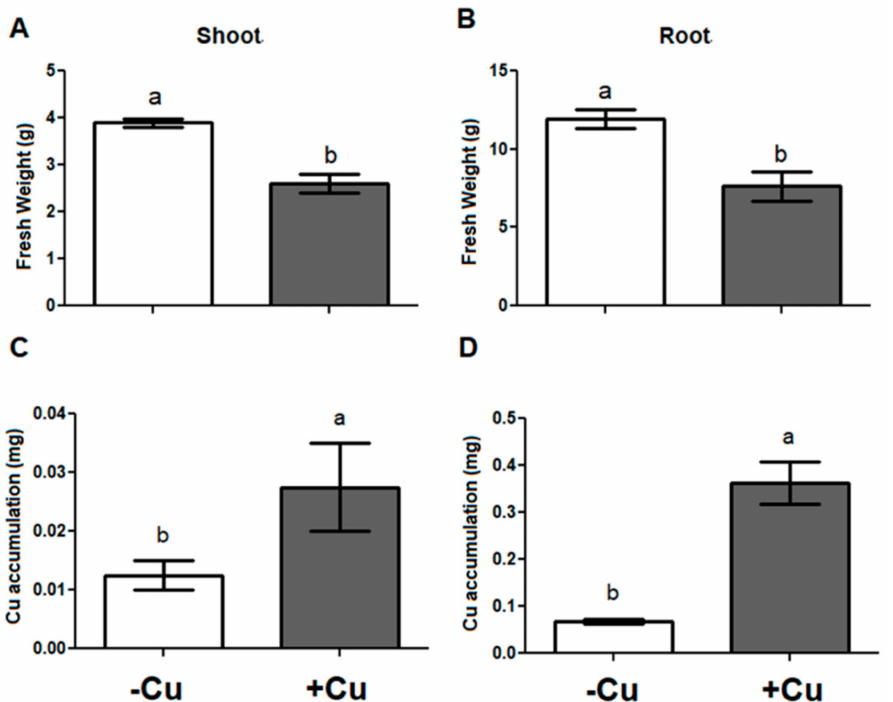
Figure 1. Biomass production (g fresh weight per experimental unit) of Imperata cylindrica : ( A ) shoots biomass, ( B ) root biomass; and Cu accumulation in ( C ) shoot and ( D ) root. –Cu, treatment without Cu applied, and +Cu treatment with addition of 300 mg Cu kg − 1 substrate. Different lowercase letters indicate differences according to t-tests for independent samples ( p < 0.05). Data are expressed as mean ± SE, n = 4.